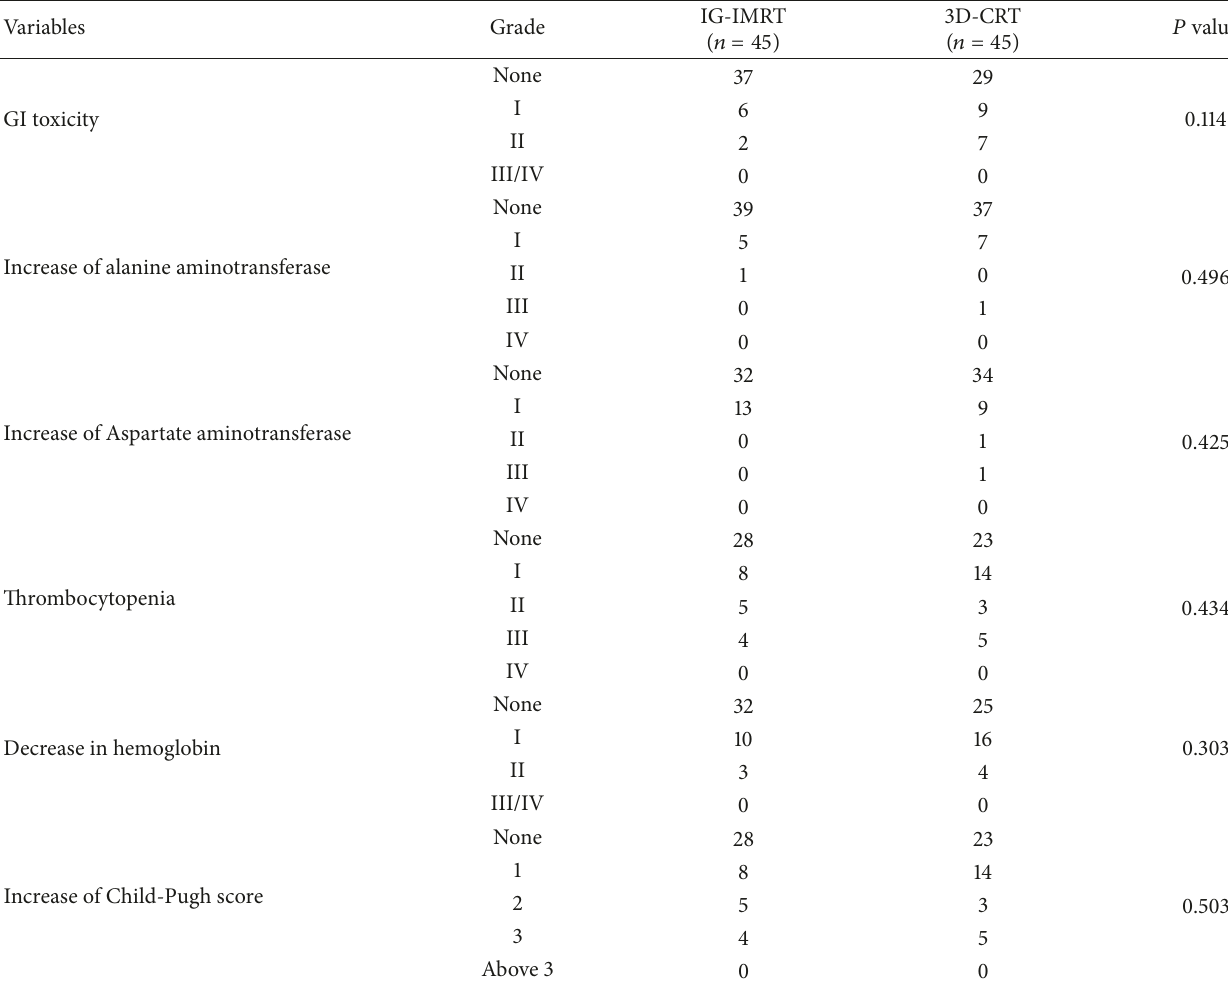
Table 4: Radiation